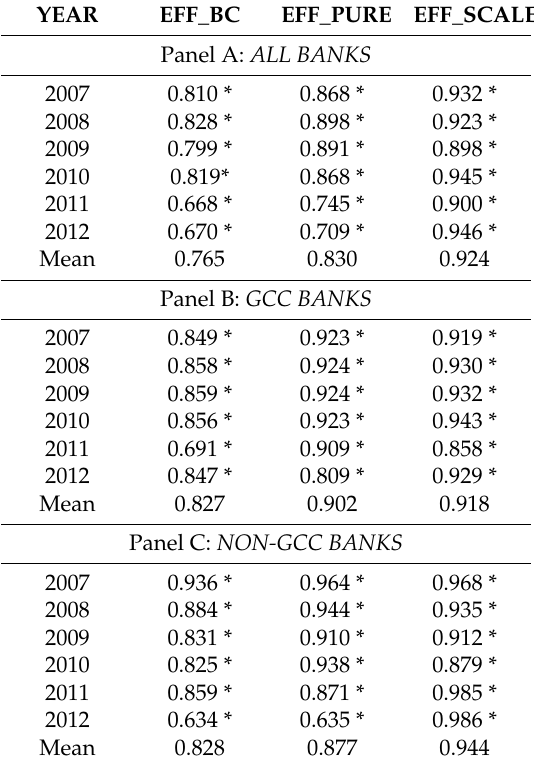
Table 3. Bias-corrected overall technical efficiency and its